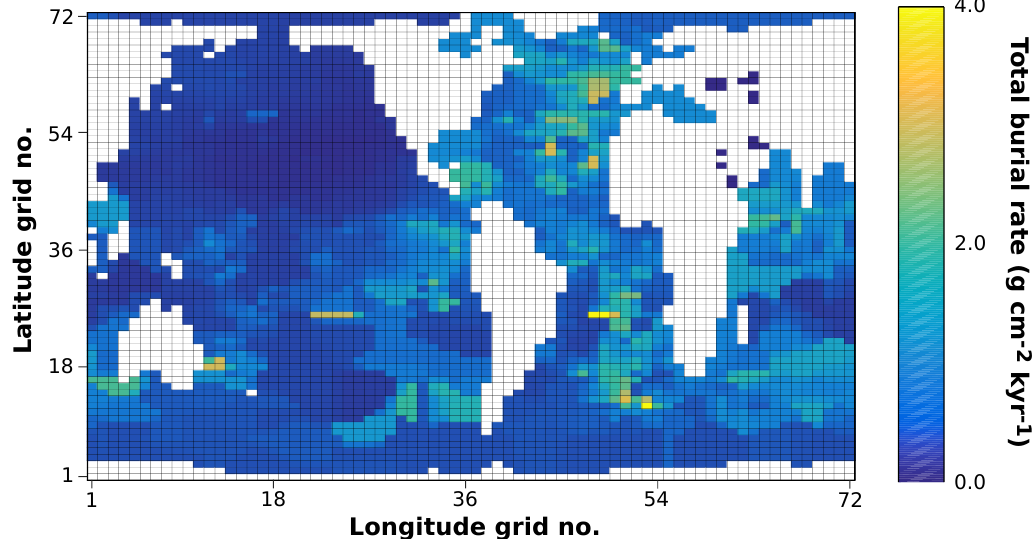
Figure C1. Distribution of prescribed total burial fluxes of detrital material, opal and CaCO 3 (in gcm − 2 kyr − 1 ) re-gridded from the data compilation of Archer (1996) using a method explained in the text. Note that latitude and longitude are shown in cGENIE grid cells and not in